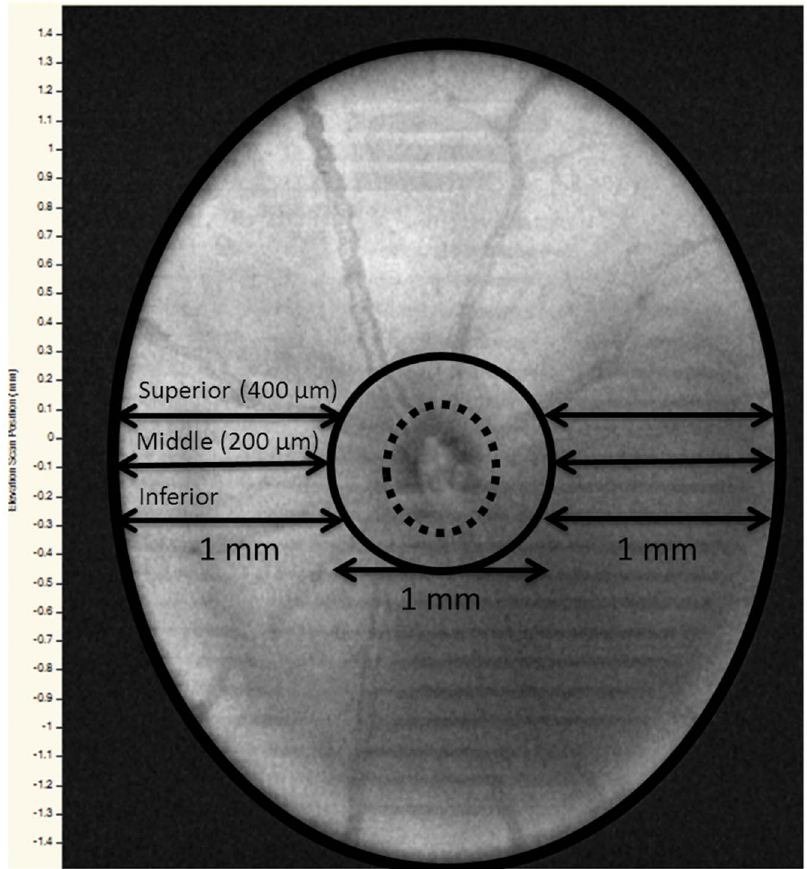
Figure 1. C57BL/6 mouse retina showing the reference points for SD-OCT and histological measurements. Dotted circle – optic nerve head (ONH); black solid circle – 1 mm diameter central area surrounding the ONH; inferior, middle and superior reference points, each 200 m m apart, both to the left and the right of the ONH.